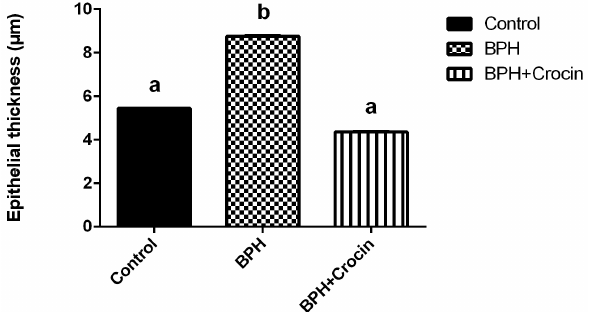
Fig. 2. Prostate epithelial thickness in the experimental rats showing the effect of crocin treatment. The results show the mean ± SEM. The significant difference was expressed as a dif- ferent superscript letter in each group ( P < 0.05). Abbreviations: BPH, benign prostatic